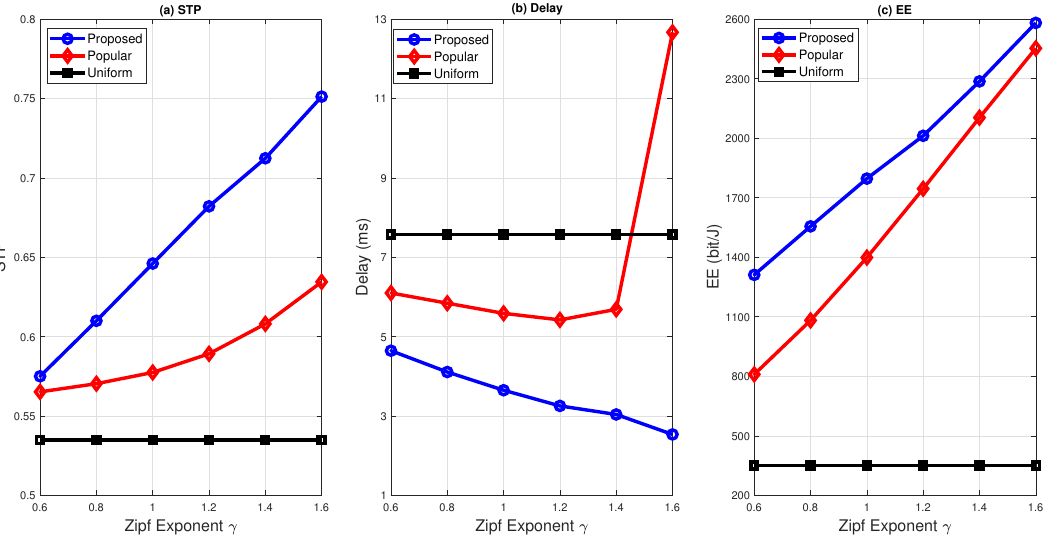
Figure 3. STP, delay, and EE versus Zipf exponent when M = 20 contents, λ U = 0.1 users/m 2 , λ F = 0.01 F-APs/m 2 , λ C = 0.0001 C-APs/m 2 , R = 150 m, α = 4, P F = 30 dBm, P C = 40 dBm, P s = 37 dBm, ρ = 15.13, W F = 100 MHz, W C = 500 MHz, T = 1 ms, and τ = 0.1